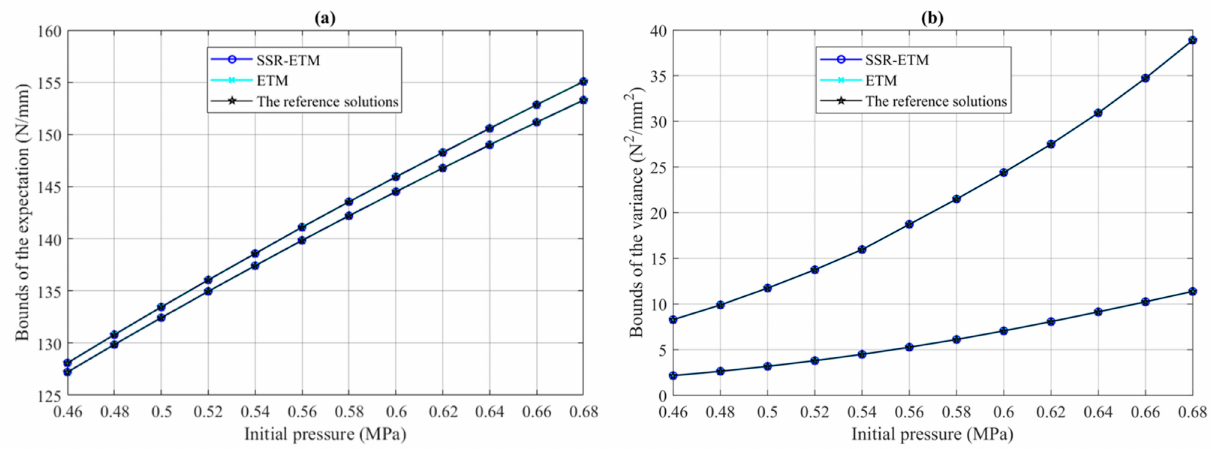
Figure 8. Bounds of the expectation ( a ) and variance ( b ) of the vertical static stiffness and their reference solutions at different initial